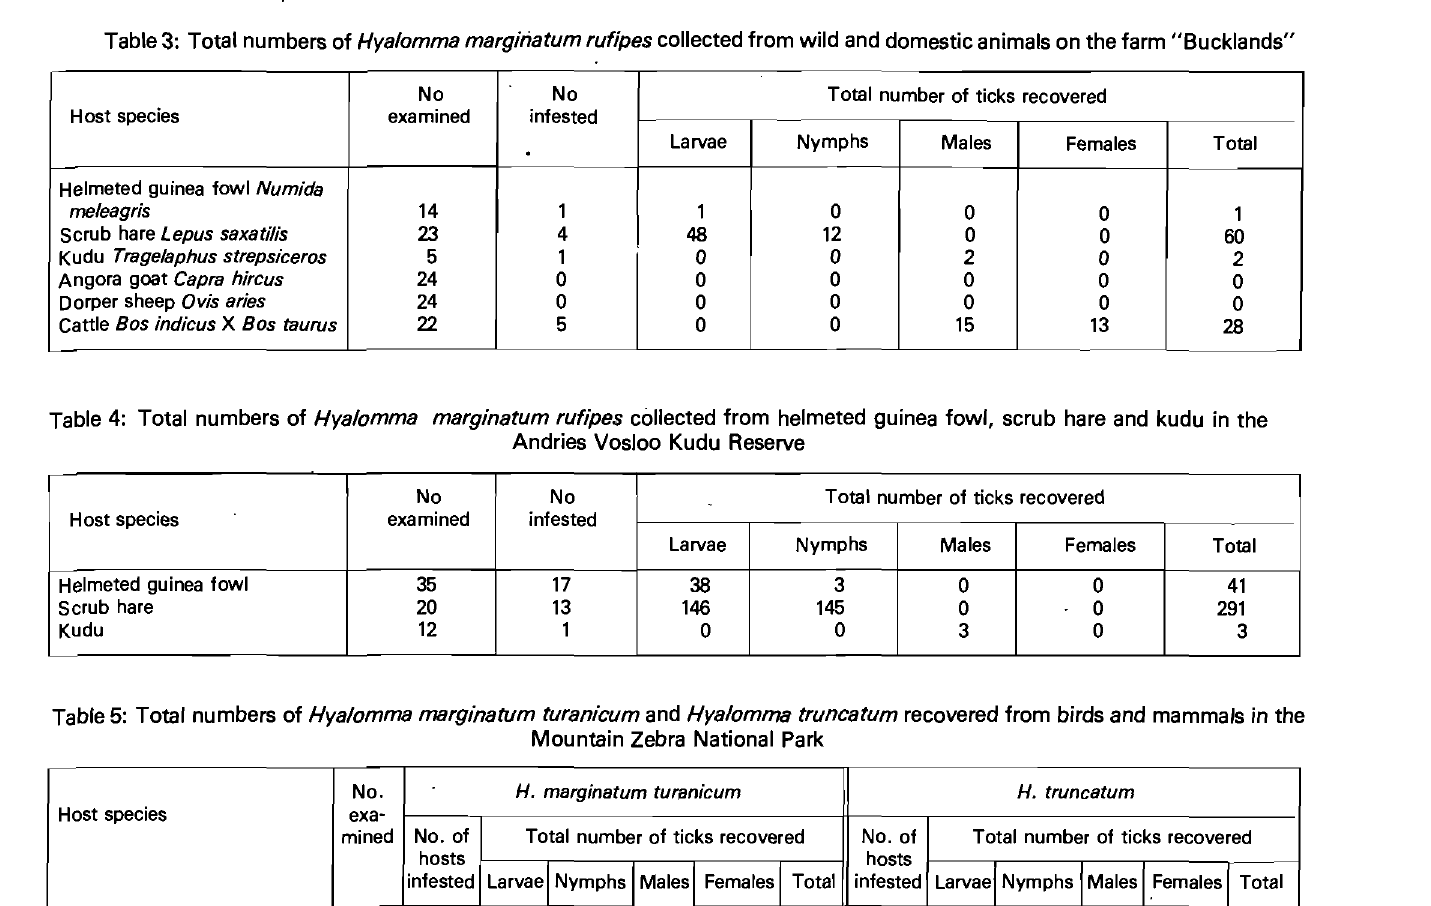
Table 3: Total numbers of Hyalomma margiilatum rufipes collected from wild and domestic animals on the farm "Bucklands" No No Total number of ticks recovered Host species examined infested Larvae Helmeted guinea fowl Numida meleagris